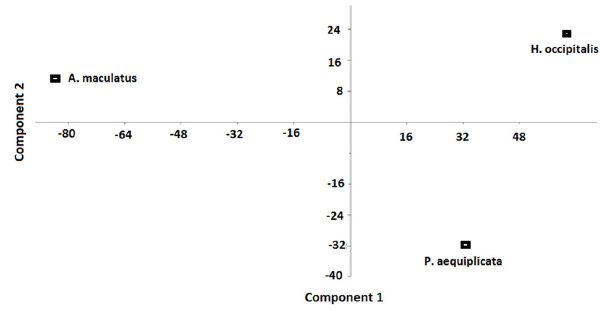
Figure 2. Scatterplot of a Principal Component Analysis classify- ing the three anuran species on the basis of the prevalence, intensity, and abundance of their gastrointestinal